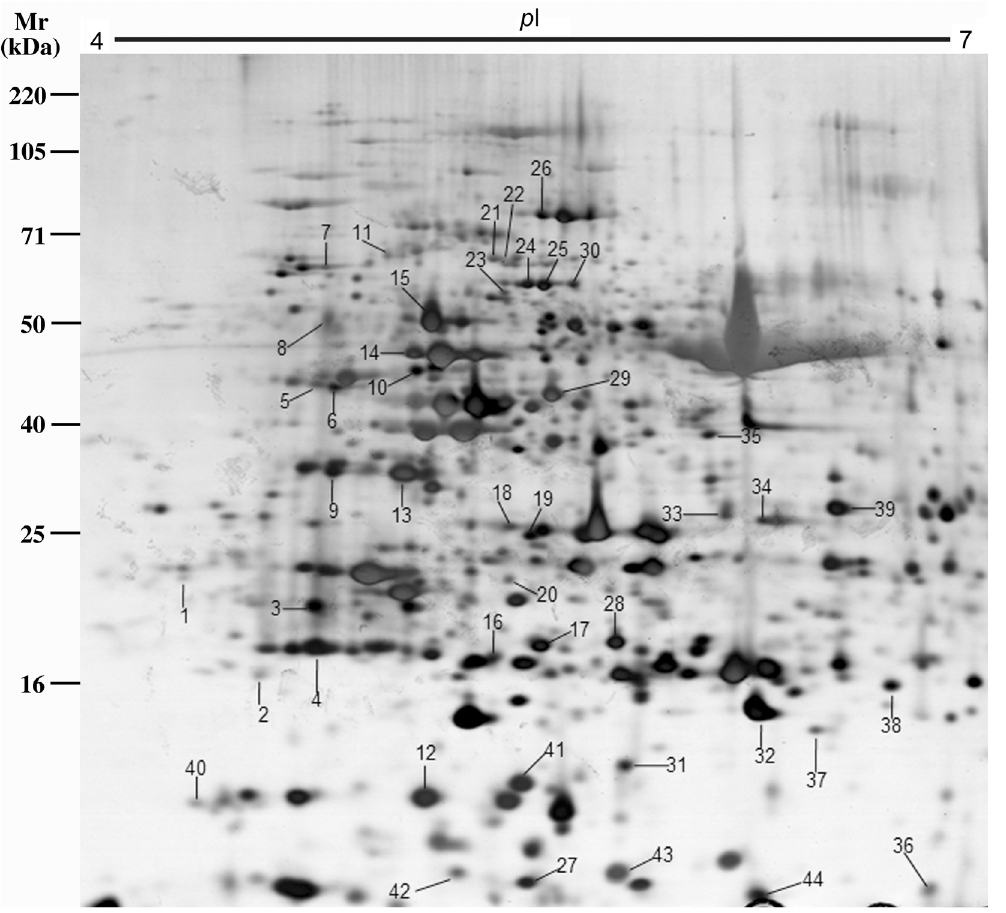
Fig 3. Two-dimensional electrophoresis (2-DE) gel images of proteins extracted from leaf 3 of B . napus ‘ Nannongyou No. 3 ’ treated with 200 mM NaCl. The 42 salt-stress-responsive protein spots identified by tandem mass spectrometry (MS/MS), which are numbered and indicated by arrows, correspond to the spot numbers in Table